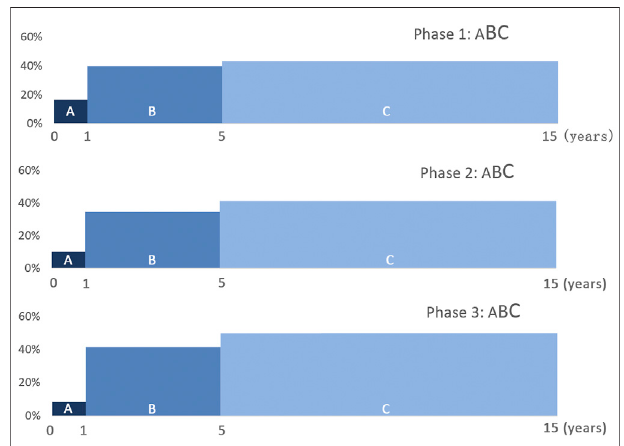
FIGURE 5 | Cull patterns of Tianluoshan sika deer. (A) : fawn; (B) : juvenile; (C) : adult. The span of each block represents the time length of a life- stage: fawn – 1 year, juvenile — 4 years, and adult — 10 years. Large letter indicates a high proportion of the life-stage.